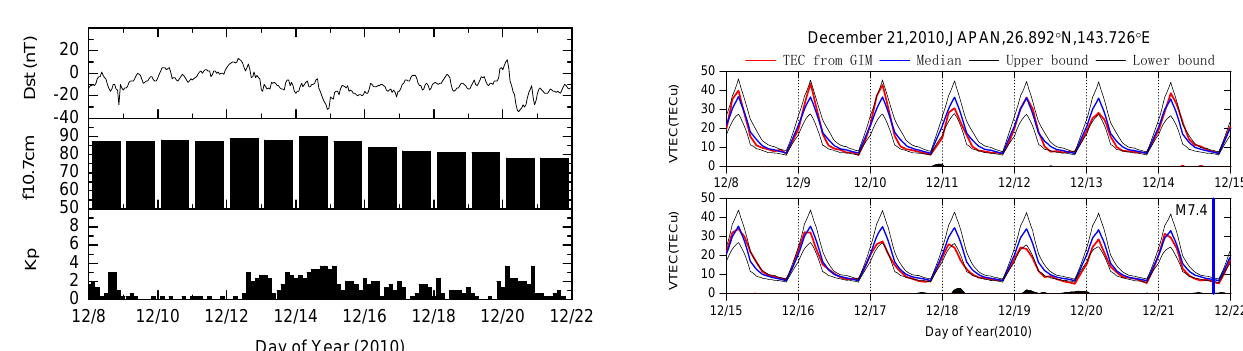
Fig. 18. Dst, F 10 . 7 , and K p indices during 8–21 December 2010.